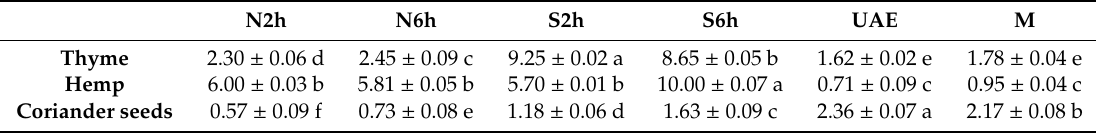
Table 1. Yields of extracts (% w / w ). N2h, RSLDE 2 h; N6h, RSLDE 6 h; S2h, Soxhlet 2 h; S6h, Soxhlet 6 h; UAE, ultrasound assisted extraction; M, maceration. N2h N6h S2h S6h UAE M Thyme 2.30 ± 0.06 d 2.45 ± 0.09 c Hemp 6.00 ± 0.03 b 5.81 ± 0.05 b Coriander